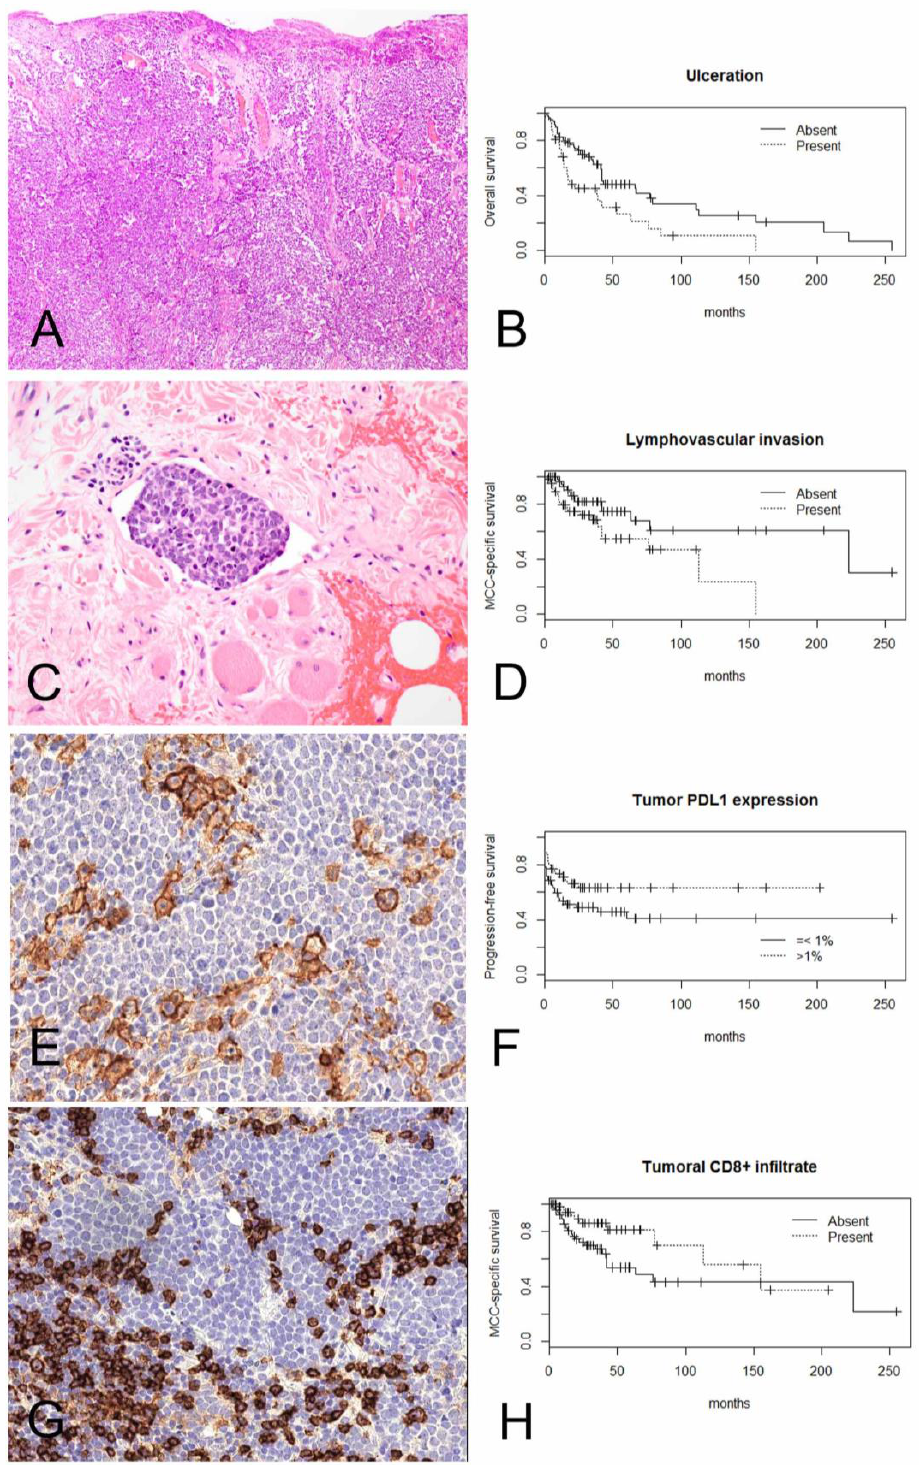
Figure 1. Kaplan–Meier curves demonstrate significant correlation between ( A ) presence of ulcer- ation (10 × ) and ( B ) worse overall survival (log-rank p = 0.0039); ( C ) presence of lymphovascular invasion (40 × ) and ( D ) worse MCC-specific survival (log-rank p = 0.02); ( E ) membranous PD-L1 expression >1% of tumor cells (20 × ) and ( F ) improved progression-free survival (log-rank p = 0.041); ( G ) intratumoral CD8+ lymphocytes and ( H ) improved Merkel cell carcinoma-specific survival (log-rank p =